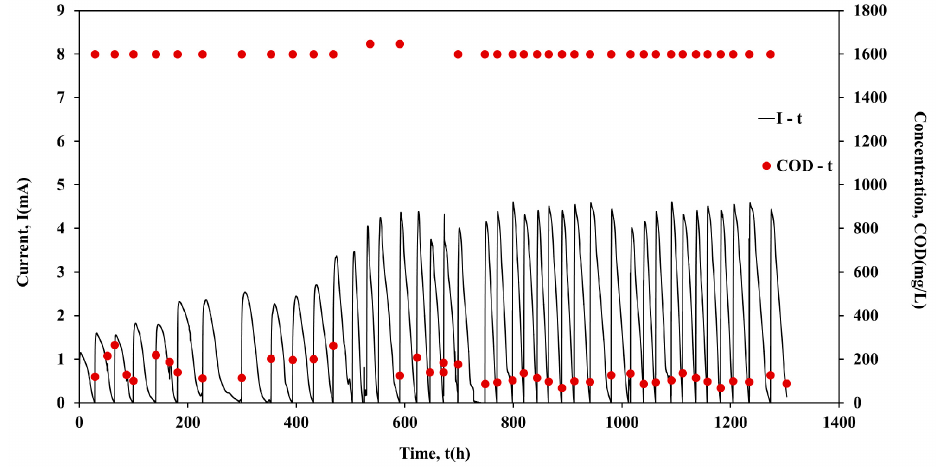
Figure 1. Current output (mA) and COD concentration (mg/L) versus time of Cell 1, during batch operation.